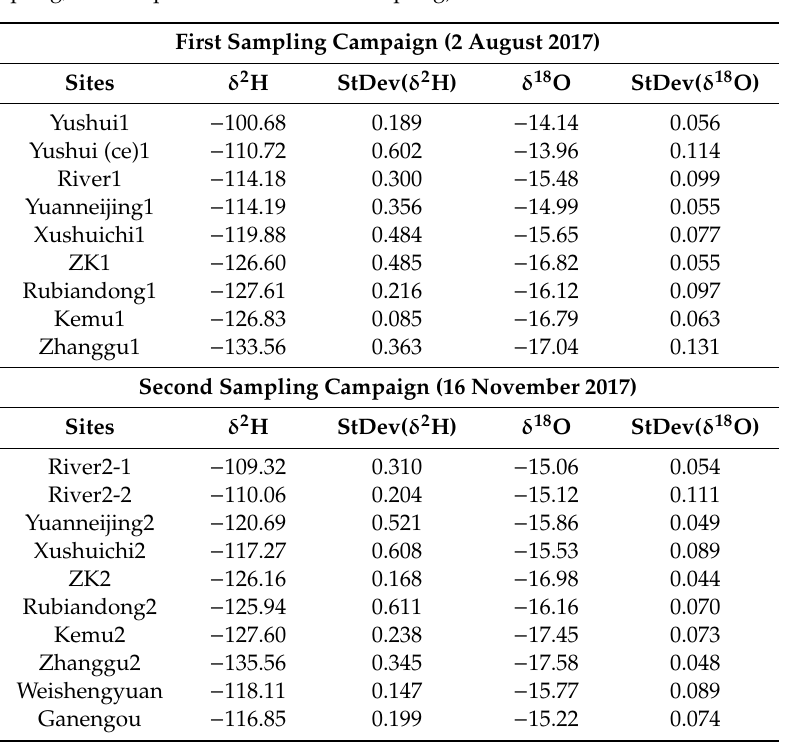
Table 2. The 2 H and 18 O activities of the water samples in two sampling campaigns (note: 1 represents the first sampling, and 2 represents the second sampling). Unit: % (cid:24)